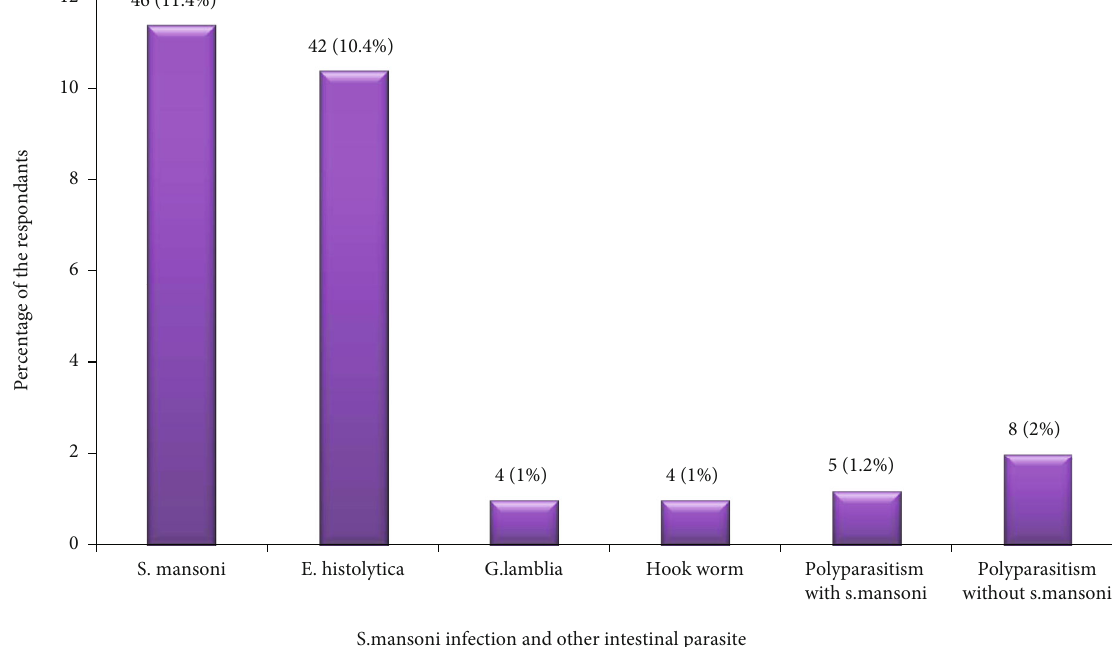
Figure 2: Prevalence of S. mansoni infection and other common intestinal parasite among study participants in Anguay kebele, Guangua district, northwest Ethiopia